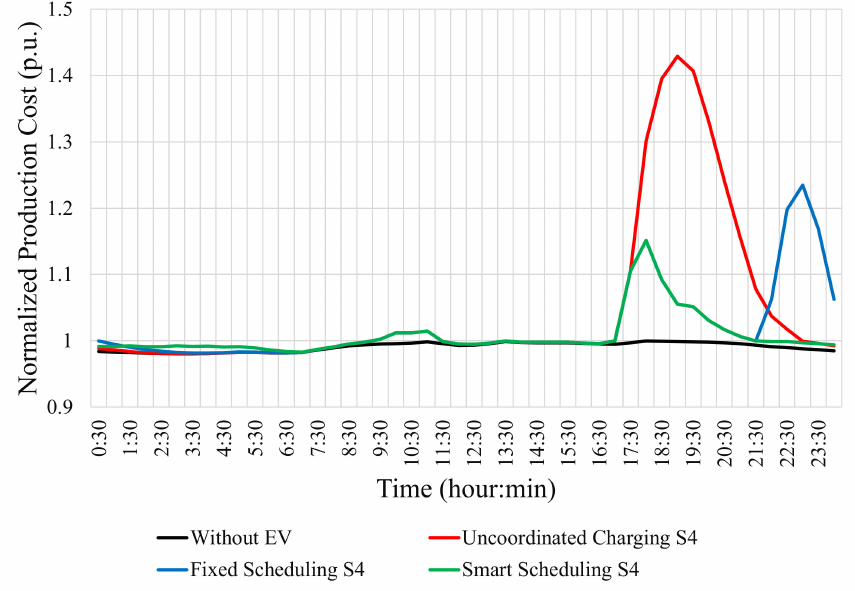
Figure 8. Hourly production cost.